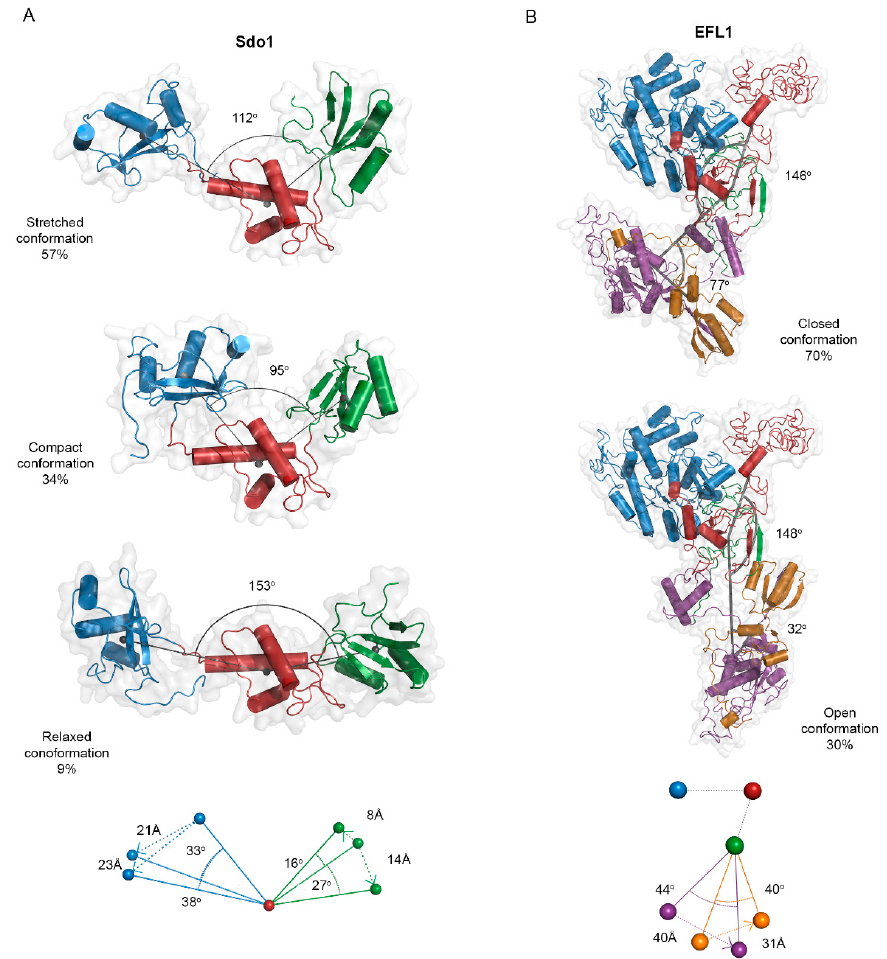
Figure 4. Ensemble of conformations for the yeast proteins Sdo1 and EFL1 in solution. ( A ) Conformational ensemble for Sdo1 in solution and their abundance percentage. Depicted angles show the movement of domain 1 (blue) and 3 (green) respective to the center of mass of domain 2 (red) within the same conformation. Bottom scheme compares the movement of these domains in the three conformations. Using as reference the position of domain 2 in the compact conformation, domain 1 moved downward in both the stretched and relaxed conformation, while domain 3 moved vertically in opposite directions in the stretched and relaxed conformations. ( B ) Conformational ensemble for the yeast EFL1 in solution and their abundance percentage. The two depicted angles show the movements of domains II (red), III (green), and IV (purple), and domains III (green), IV (purple) and V (gold) compared to domain I (blue) within the same conformation. Using as reference the position of domains I, II, and III, the bottom scheme compares the movement of domain IV and V.